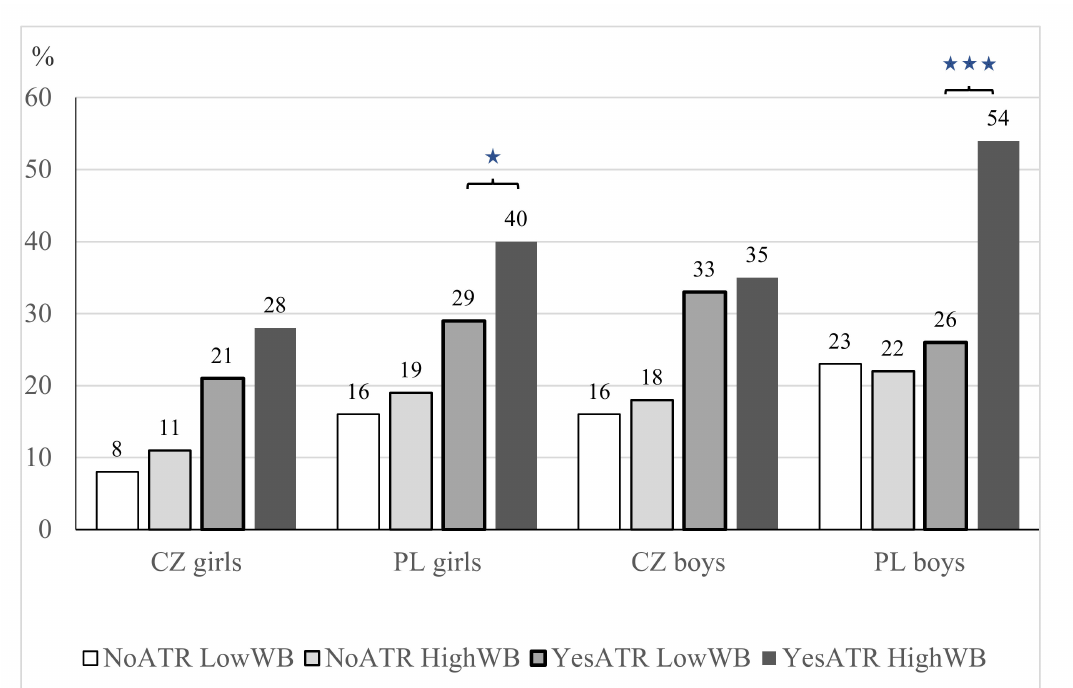
Figure 1. Rates of meeting the weekly physical activity (PA) recommendations (at least five times 60 min of moderate-to-vigorous PA (MVPA) and at least three times 20 min of vigorous PA (VPA)) in Czech (CZ) and Polish (PL) girls and boys by level of well-being (WB) and meeting active travel recommendation (ATR) (at least five or more days per week for 30 or more minutes of active travel